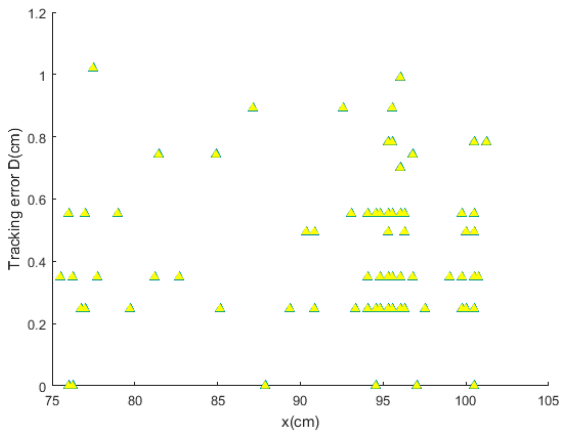
Figure 14. The tracking error D.